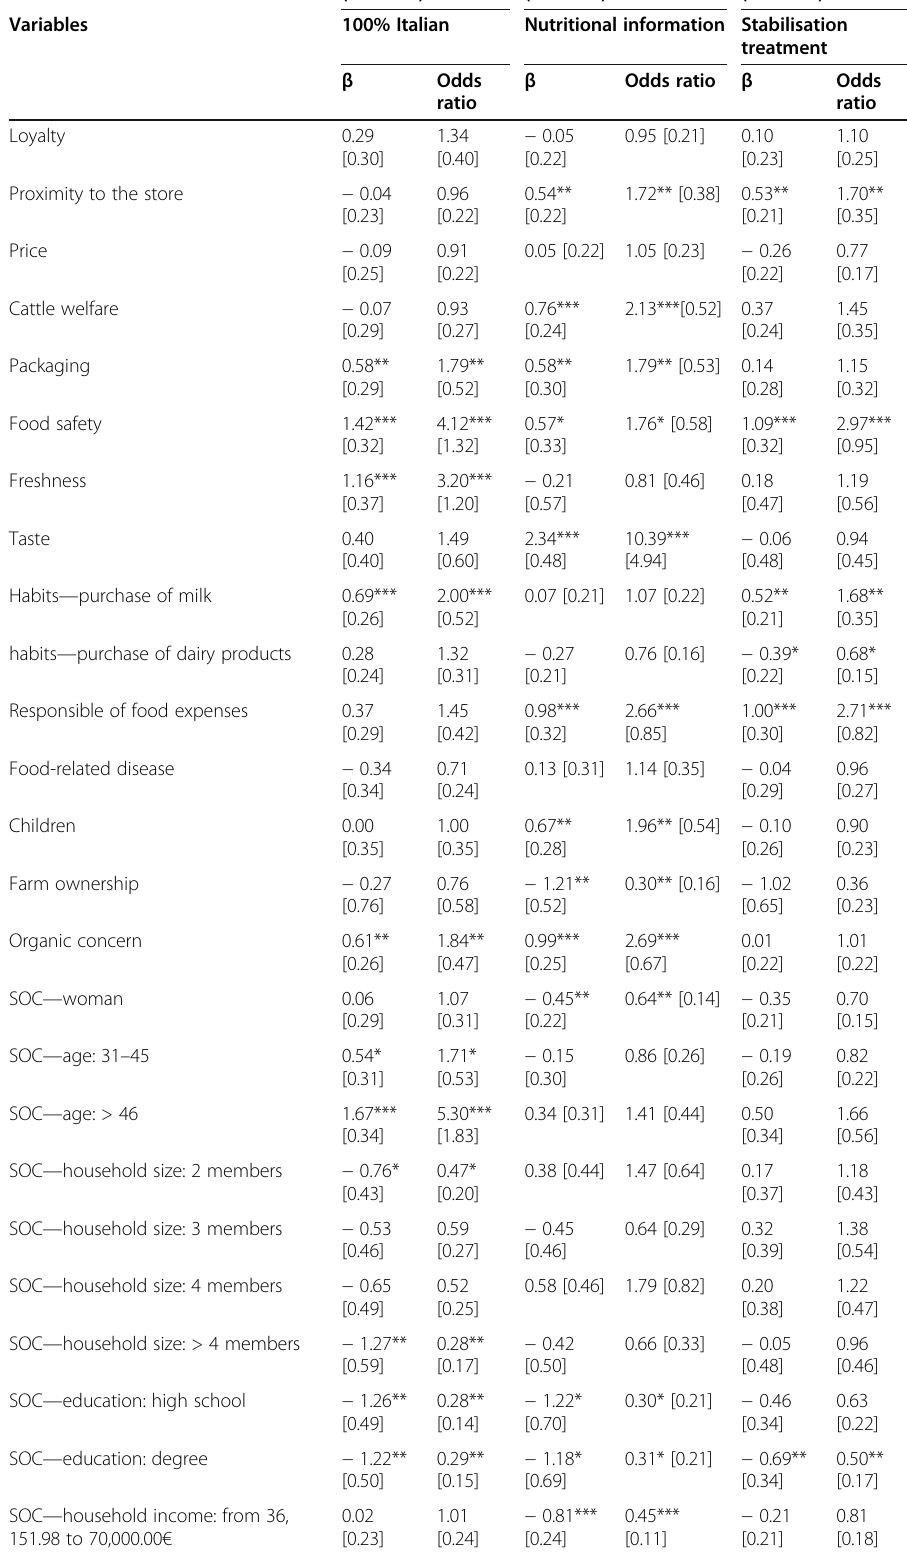
Table 3 Model estimation: beta coefficients and odds ratio for mandatory label